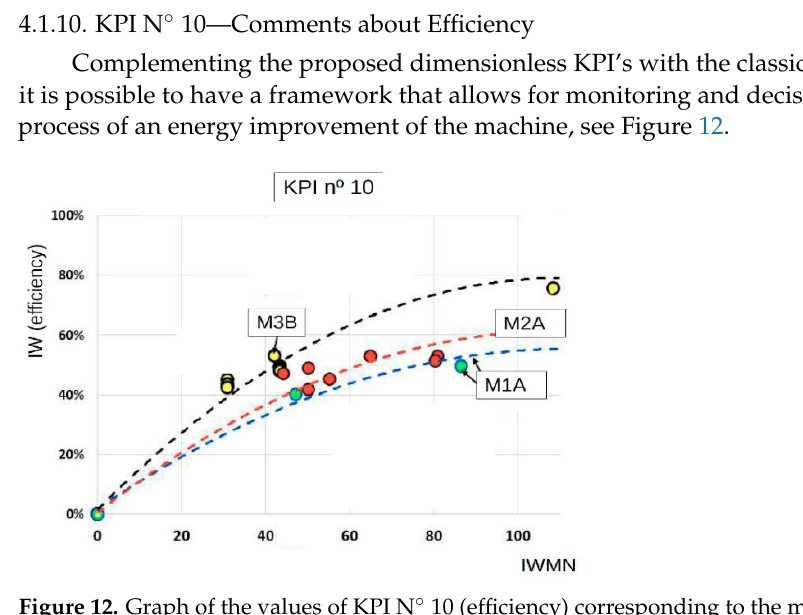
Figure 11 . Graph of the values of IW li corresponding to the machines whose data were analyzed.